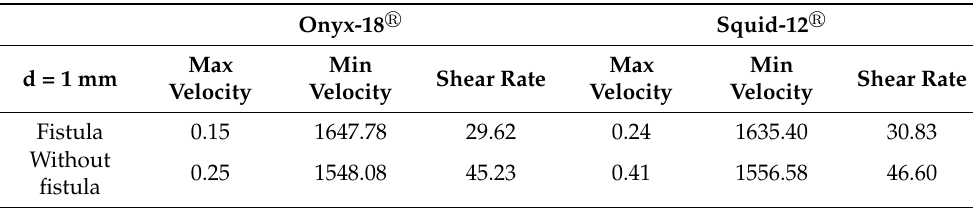
Table 2. Velocity and shear rate results of numerical calculations in the configuration with and without